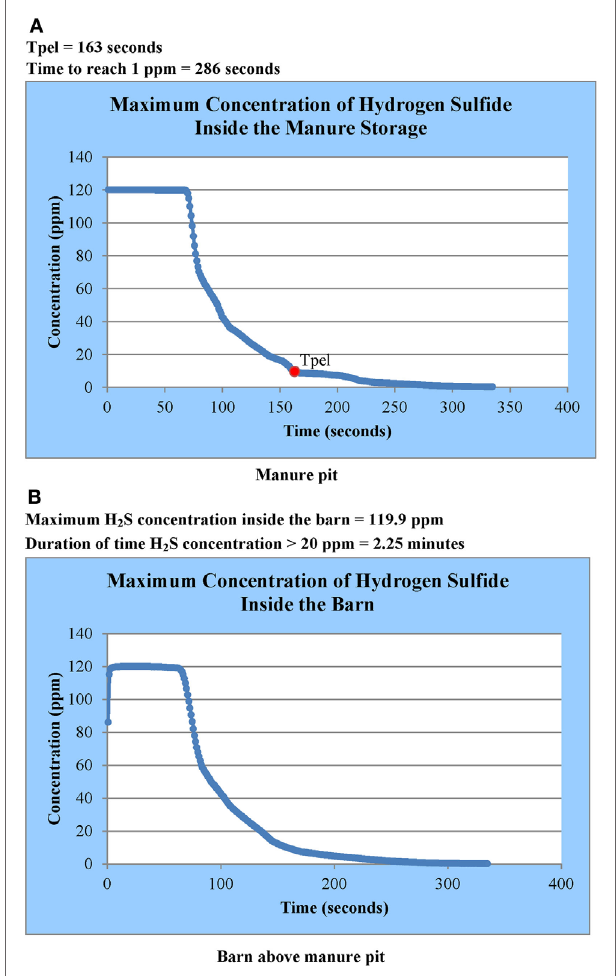
FIgURe 9 | hydrogen sulfide decay curves in (A) manure pit and (B) barn above the manure pit for case Study 1: slotted-covered manure pit beneath a tunnel-ventilated (parallel flow) barn .